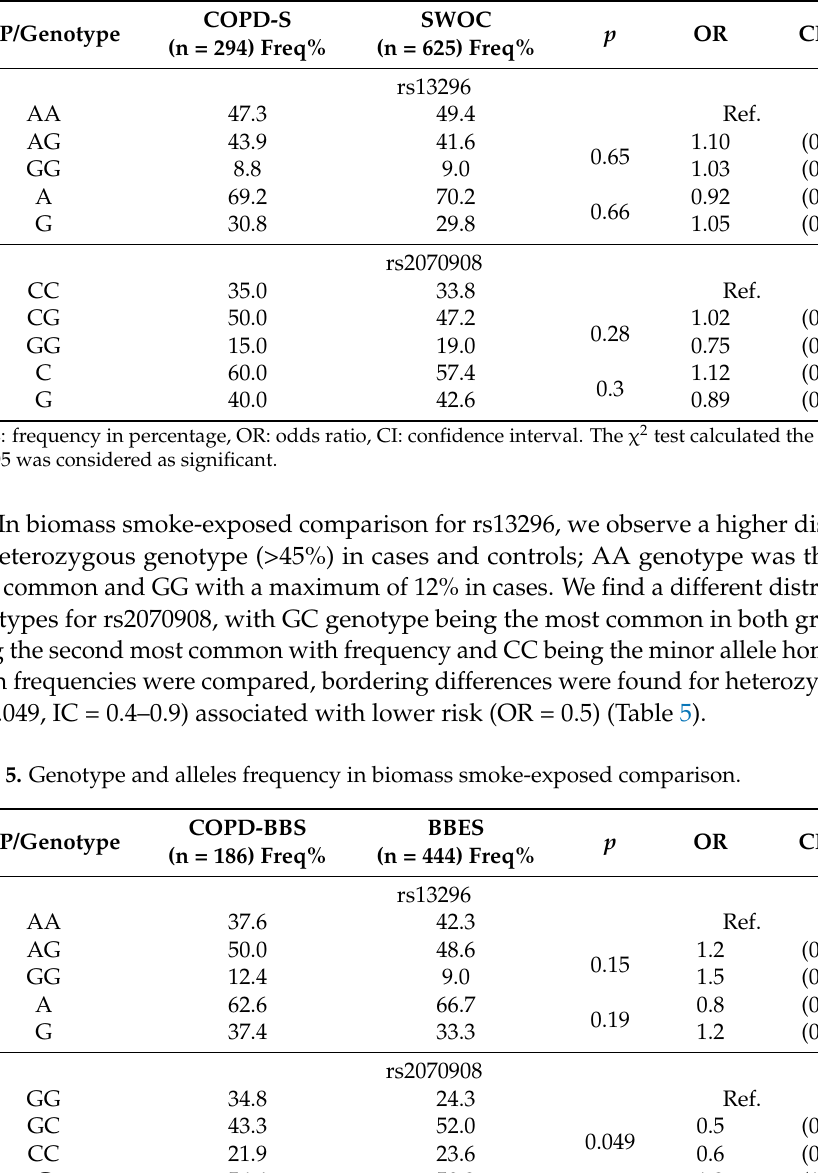
Table 4. Genotype and allele frequencies in the tobacco smoking groups.